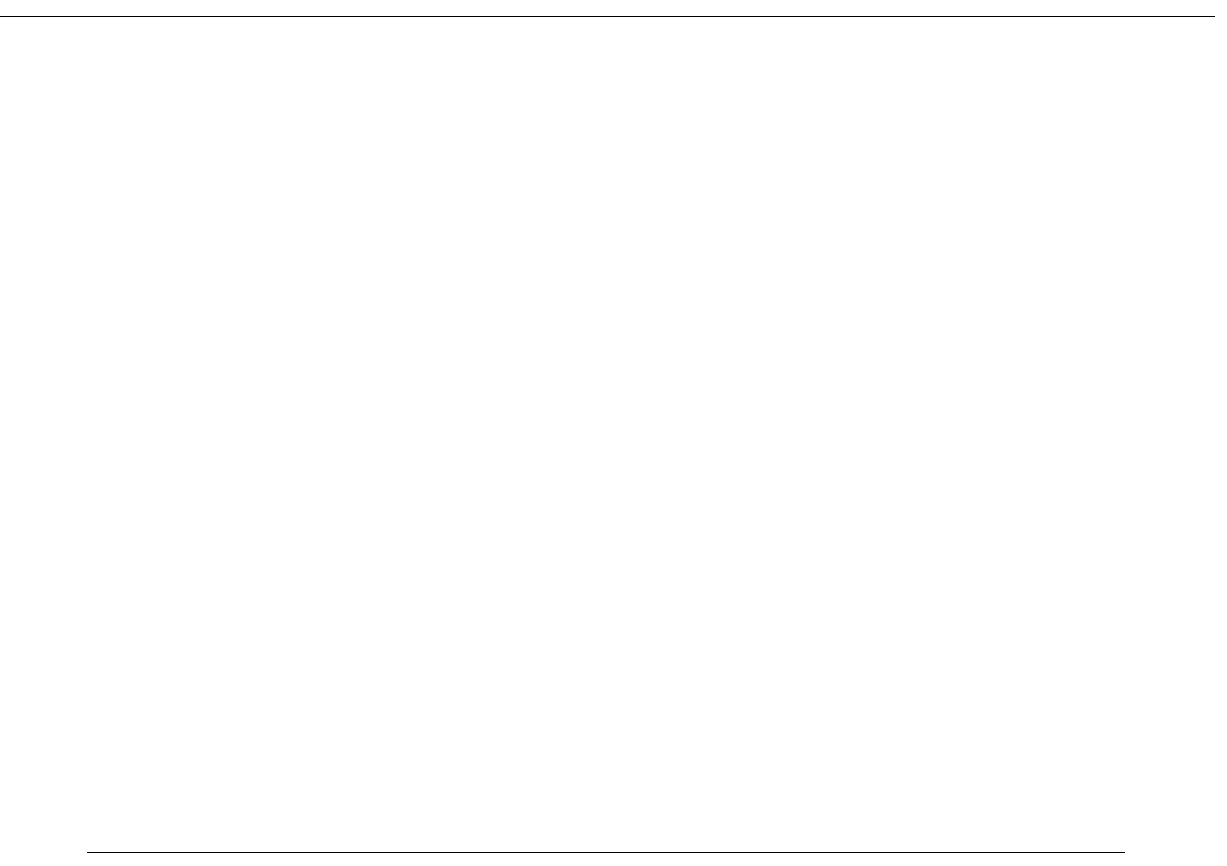
Figure 1: Descriptio Maris Pacific Descriptio Maris Pacific was the first dedicated map of the Pacific to be printed (public domain, https://commons.wikimedia.org/w/